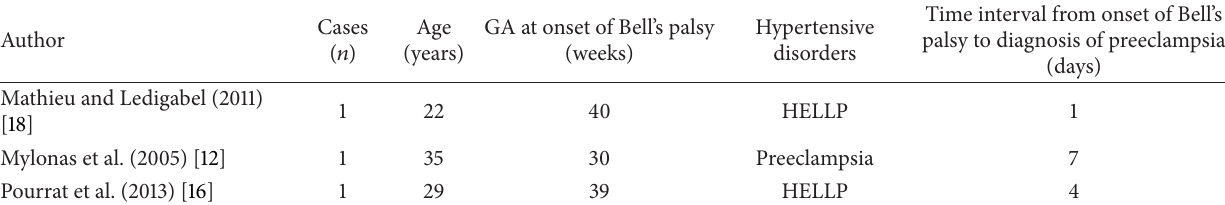
Table 2: Postpartum Bell’s